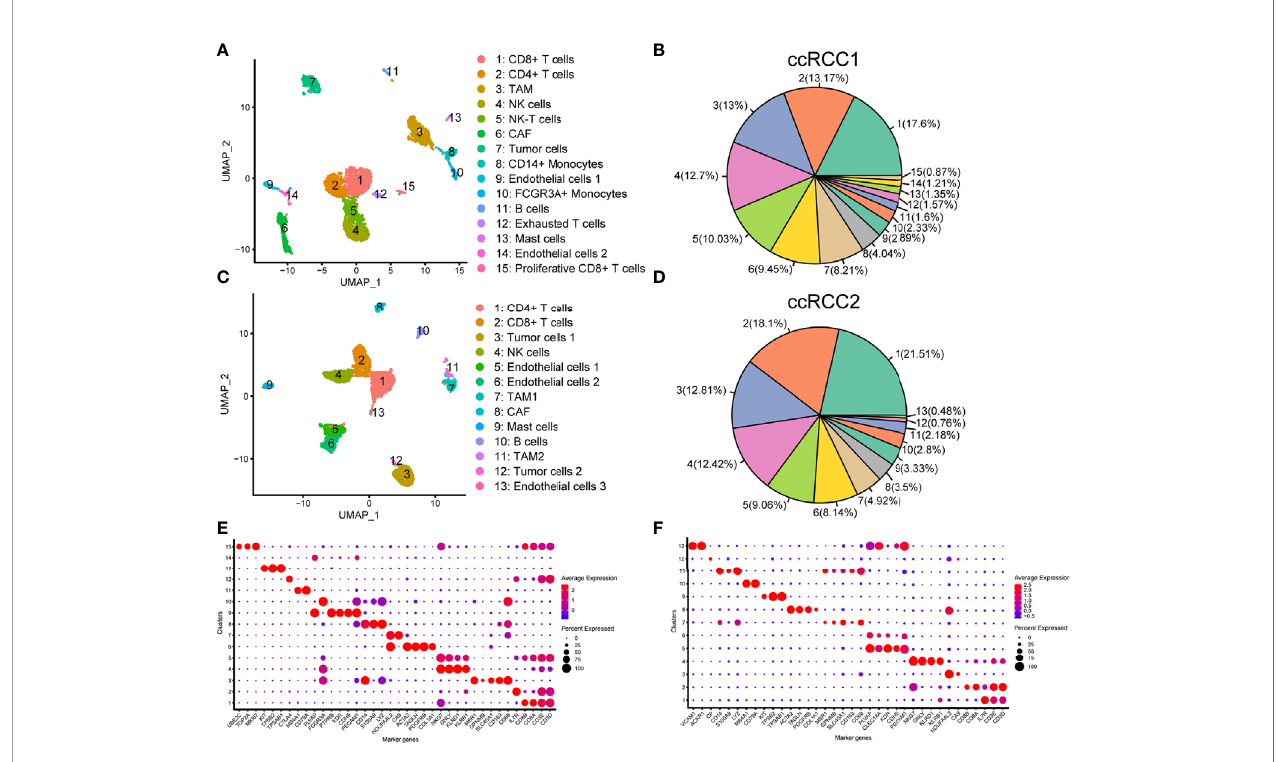
FIGURE 3 | Single-cell transcriptomic map of sporadic bilateral ccRCC. (A) Uniform manifold approximation and projection (UMAP) plot representation of right tumour (ccRCC1) with 15 distinct cell types. (B) Proportion of each cell type in ccRCC1. (C) UMAP plot representation of left tumour (ccRCC2) with 13 distinct cell types. (D) Proportion of each cell type in ccRCC2. (E, F) Bubble chart showing the marker genes of each cluster in ccRCC1 (E) and ccRCC2 (F) ; the selected marker genes for each cluster are